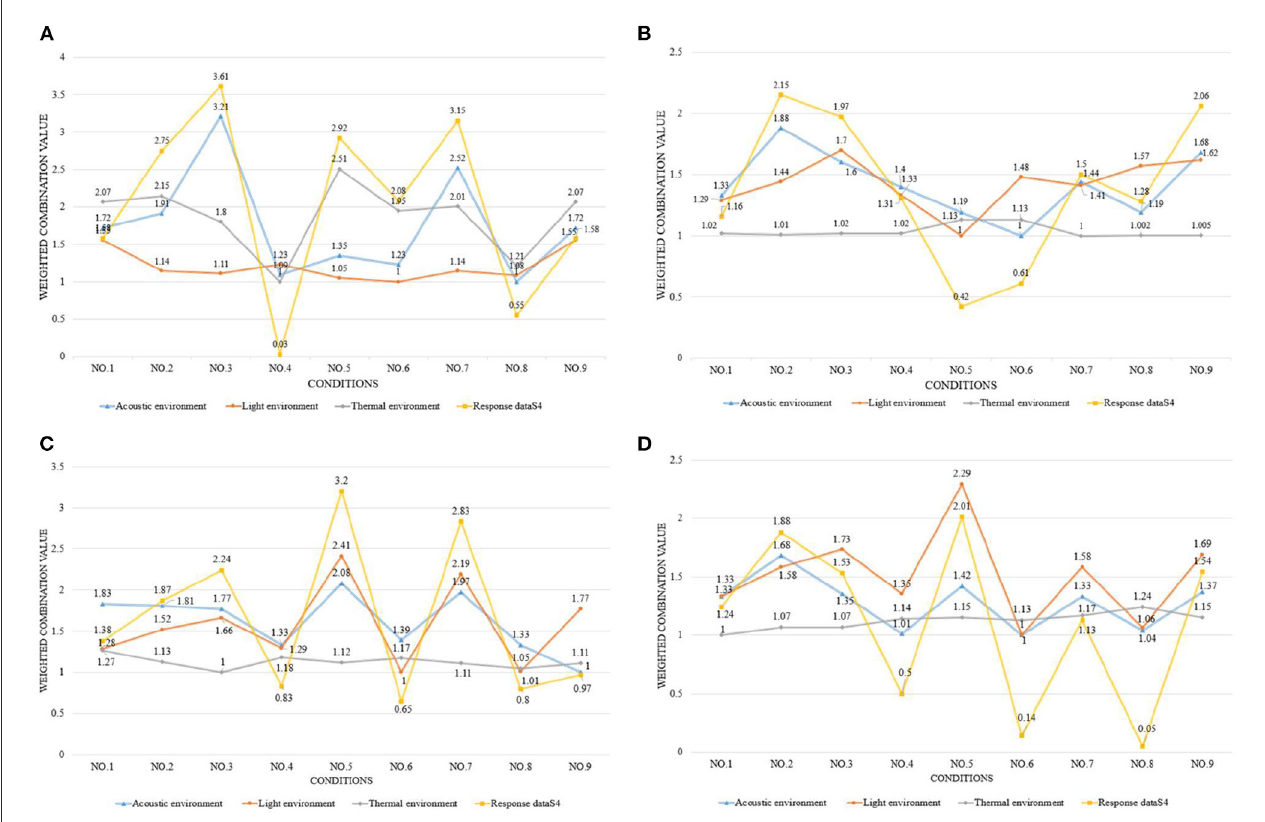
FIGURE7 Physical environment simulation results and response values for (A) TUAI, (B) TCAI, (C) TCSI, and (D) THAI. Image source: self-drawn by the